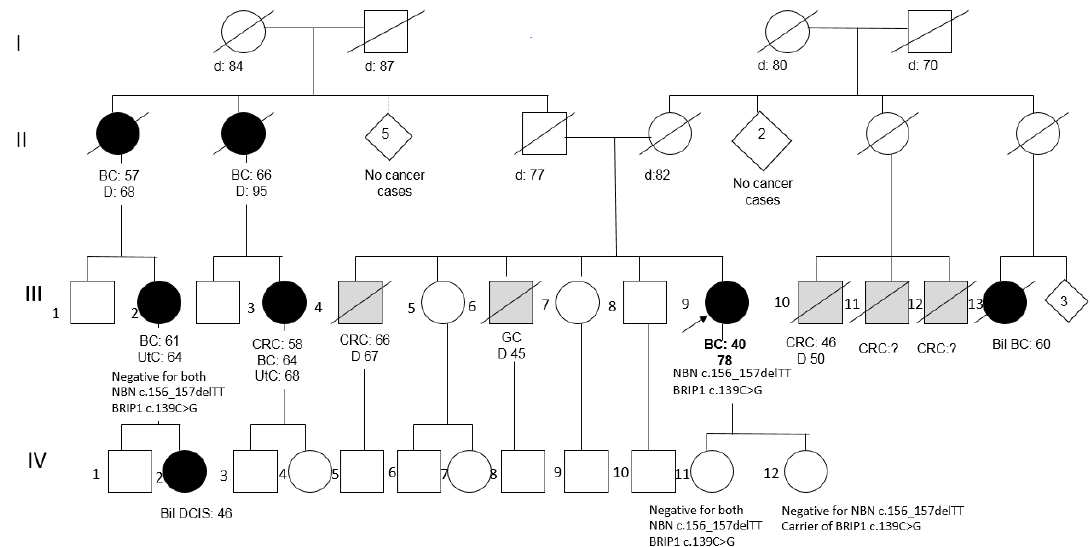
Figure 2. Pedigree of Patient 2 (BC = Breast Cancer; Bil = Bilateral; DCIS = Ductal Carcinoma In Situ; CRC = Colorectal Cancer; GC = Gastric Cancer; UtC = Uterine Cancer).